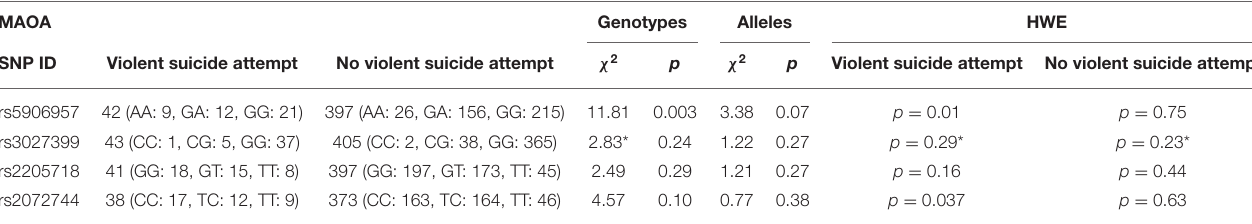
TABLE 1 | Female subsample: personal history of violent suicide attempt vs. no history of violent suicide attempt, single marker analyses were established with standard chi-squared testing. MAOA Genotypes Alleles HWE Violent suicide